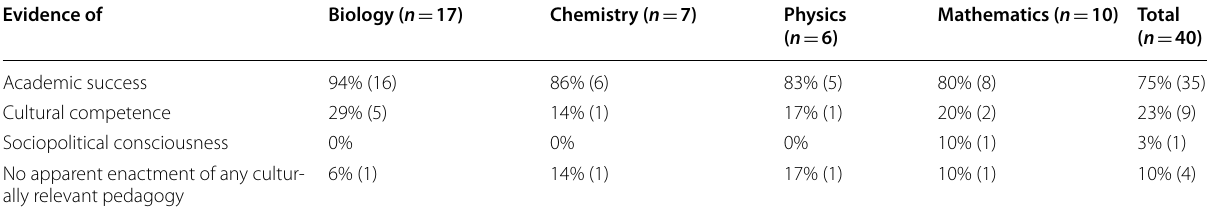
Columns can sum to more than n because participants often expressed more than one tenet of CRP